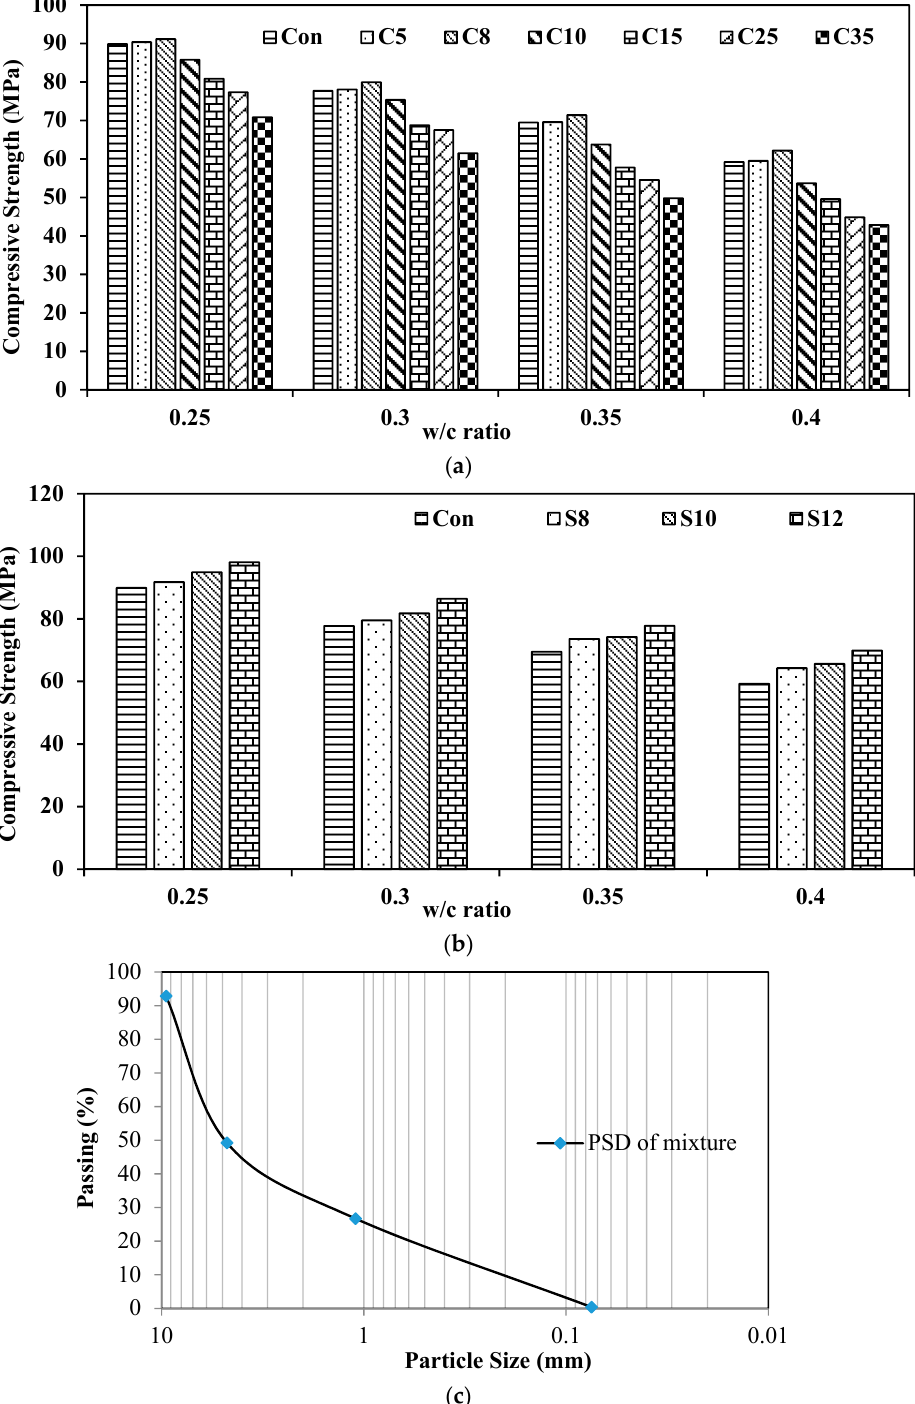
Figure 4. Compressive strength vs. w/c ratio for ultrafine and silica fume dosages. ( a ) Compressive strength vs. w/c ratio for UF dosages; ( b ) compressive strength vs. w/c ratio for SF dosages; ( c ) particle size distribution of concrete mixtures.